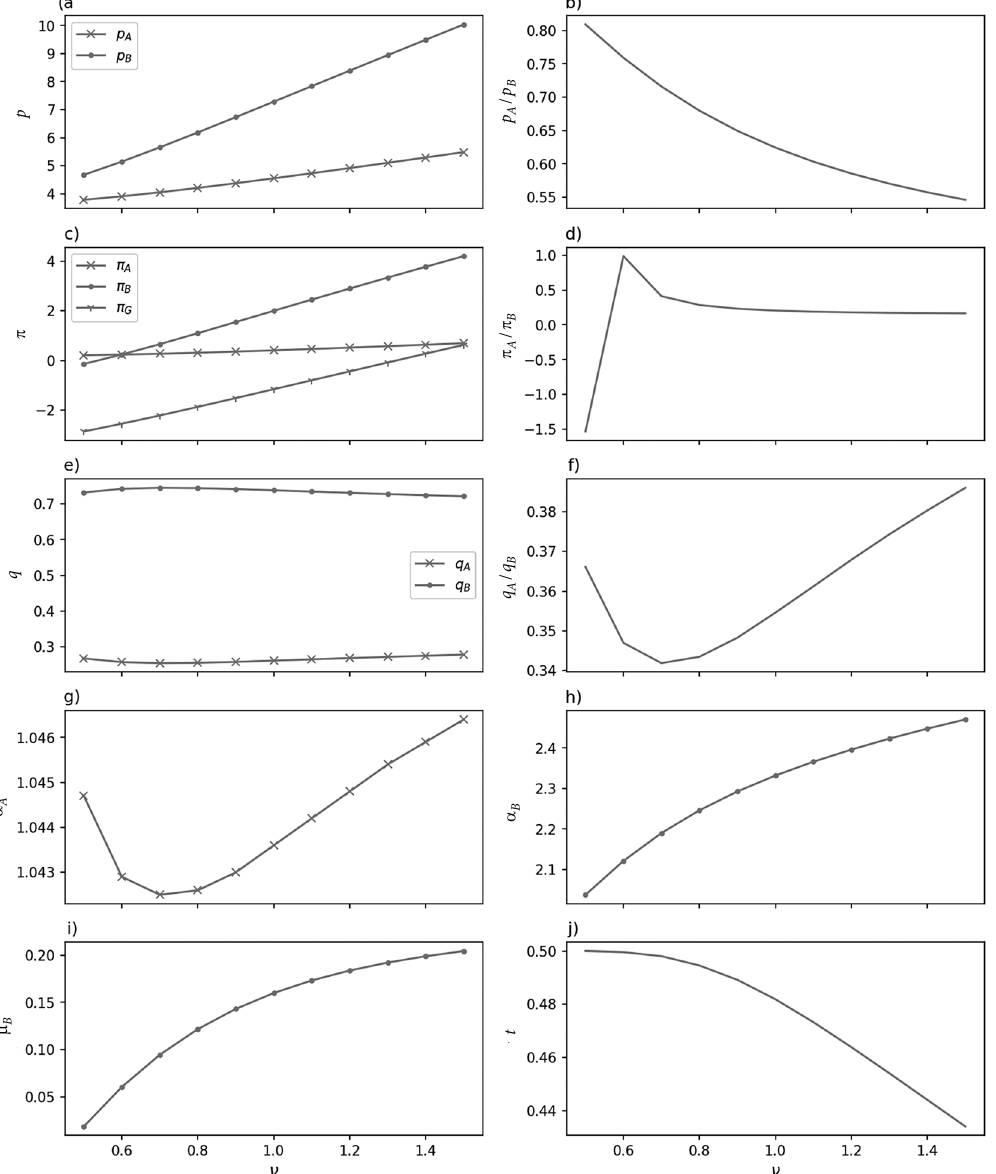
Figure 2. Plots of the dynamic changes of all the factors caused by changes in consumer